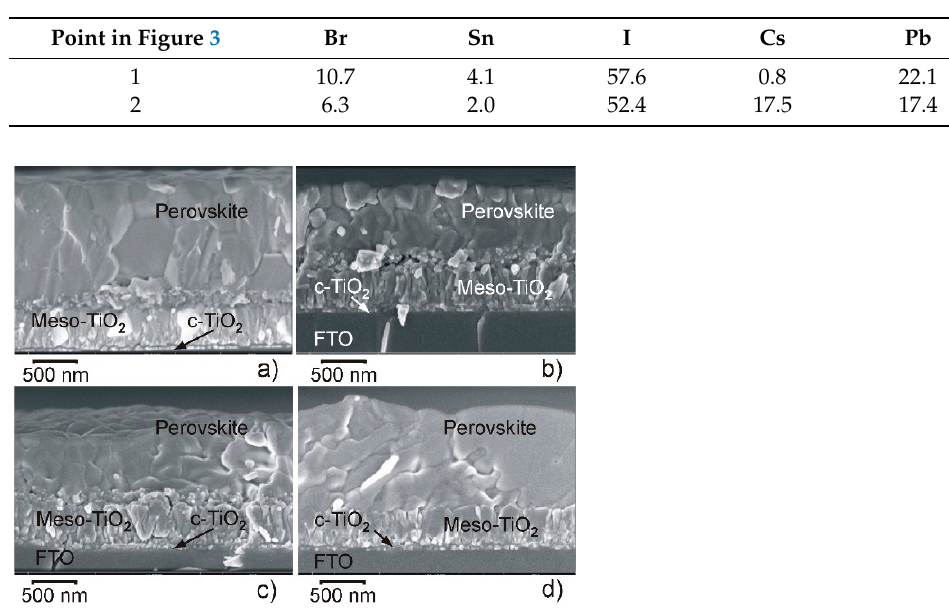
Table 1. Elemental composition of the 30% CsI containing perovskite film surface, atomic % (oxygen and titanium values not included). Figure 3. Surface SEM image ( a ) and mapping images of EDX analysis of 30% CsI containing perovskite layer corresponding to bromine ( b ), tin ( c ), iodine ( d ), cesium ( e ), and lead ( f ) mapping.